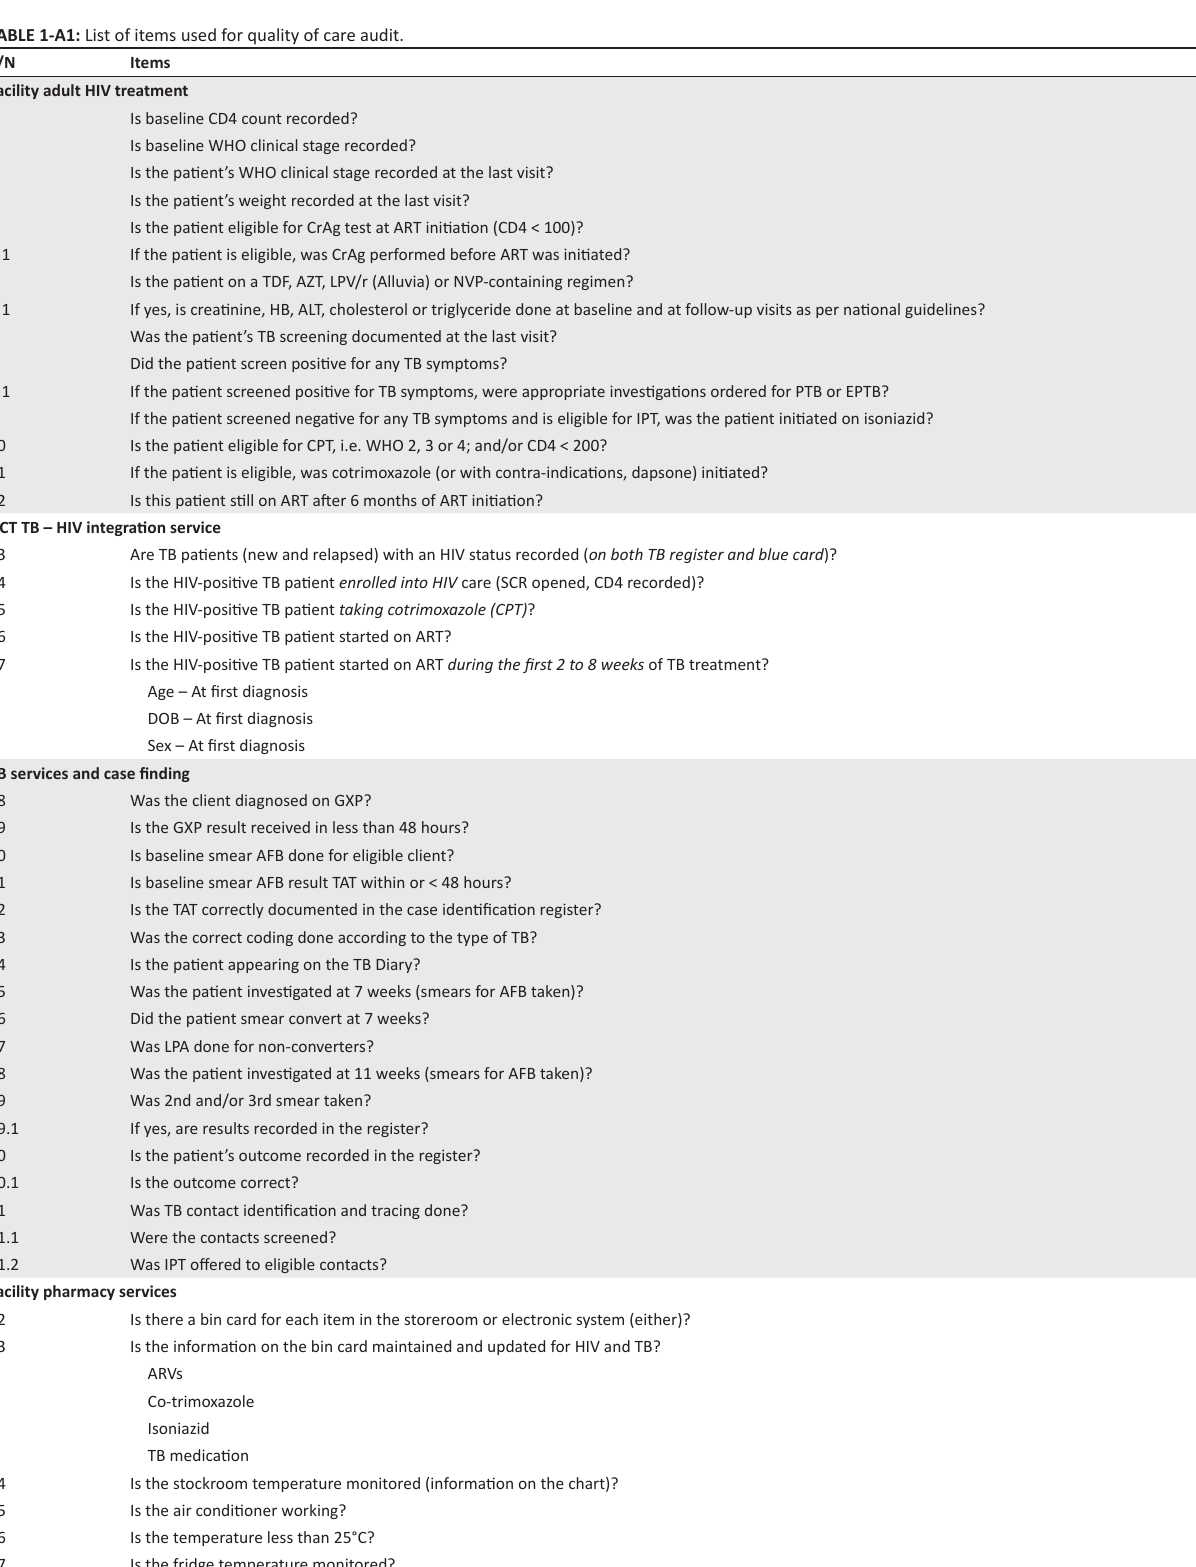
TABLE 1-A1: List of items used for quality of care